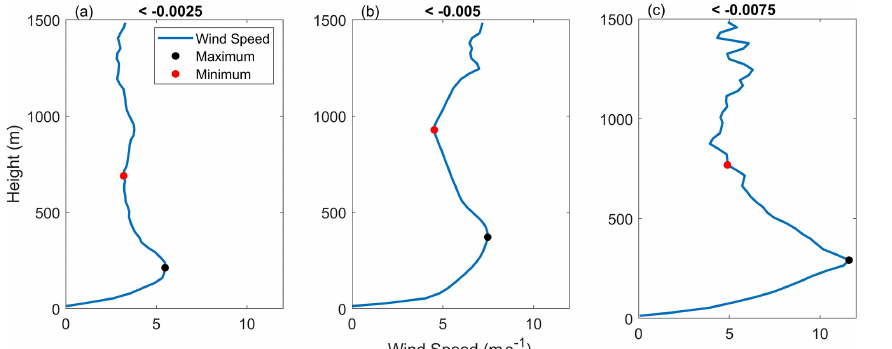
Figure 2. Examples of NLLJ profiles identified with wind shear between the jet core and the minimum above it with the thresh- olds < − 0 . 0025s − 1 (a) , < − 0 . 005s − 1 (b) and < − 0 . 0075s − 1 (c) .